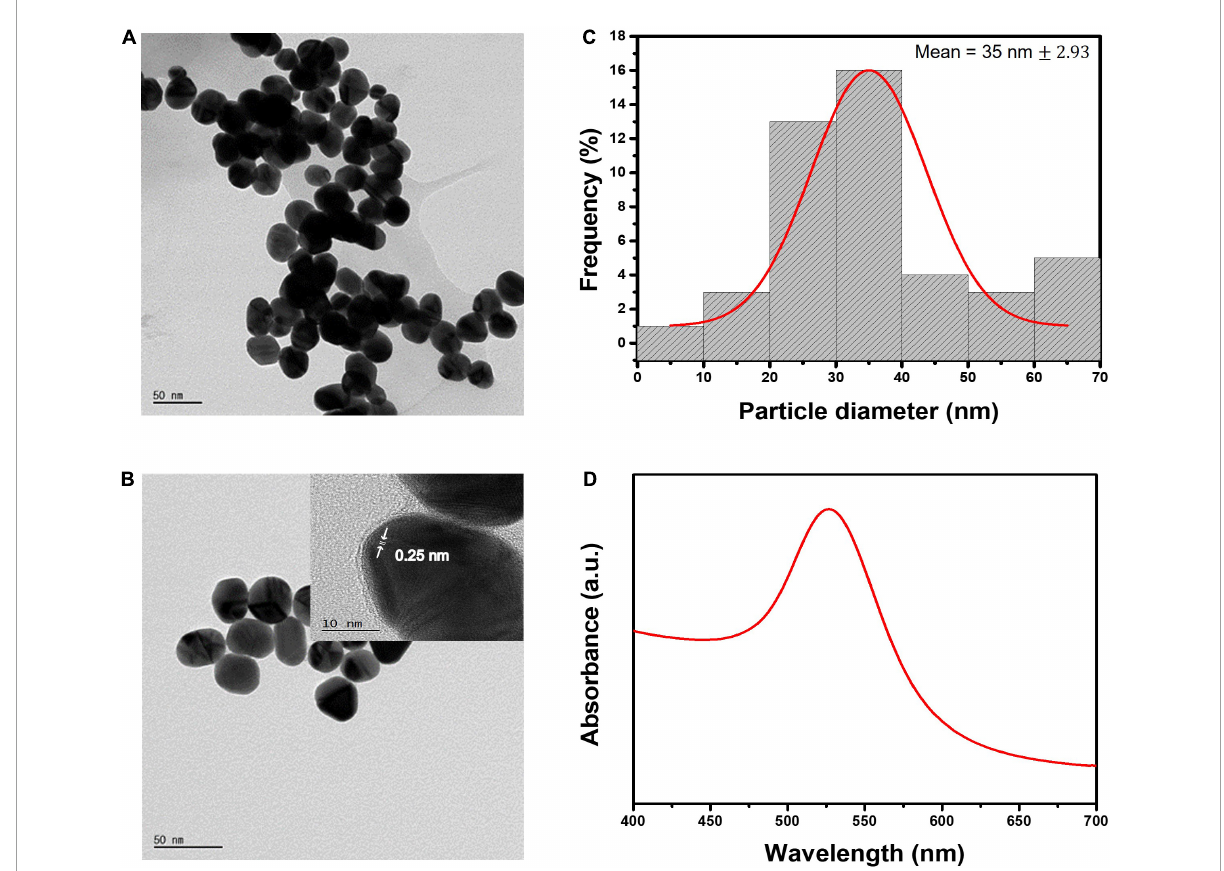
FIGURE2 Characterization of AuNPs. (A,B) FE-TEM images of AuNPs and the inter-planar spacing. (C) Size distribution histogram of 35 nm AuNPs. (D) UV-vis absorption spectra of 35 nm gold colloidal